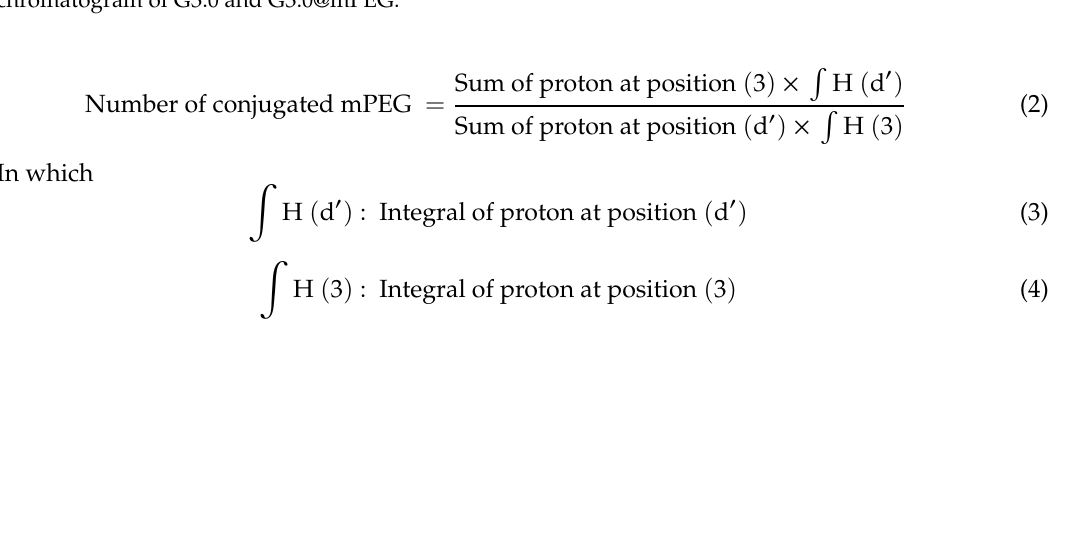
Figure 2. Proton nuclear magnetic resonance ( 1 H-NMR) (D 2 O, δ in ppm) spectra of ( a ) mPEG-NPC, ( b ) PAMAM G3.0, ( c ) PAMAM G3.0@mPEG, and ( d ) Gel permeation chromatography (GPC) chromatogram of G3.0 and